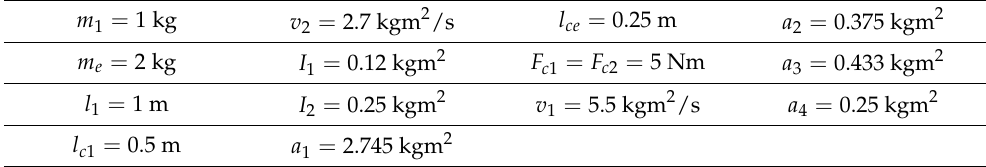
Table 1. Parameters of the upper-limb exoskeleton robot system. m 1 = 1